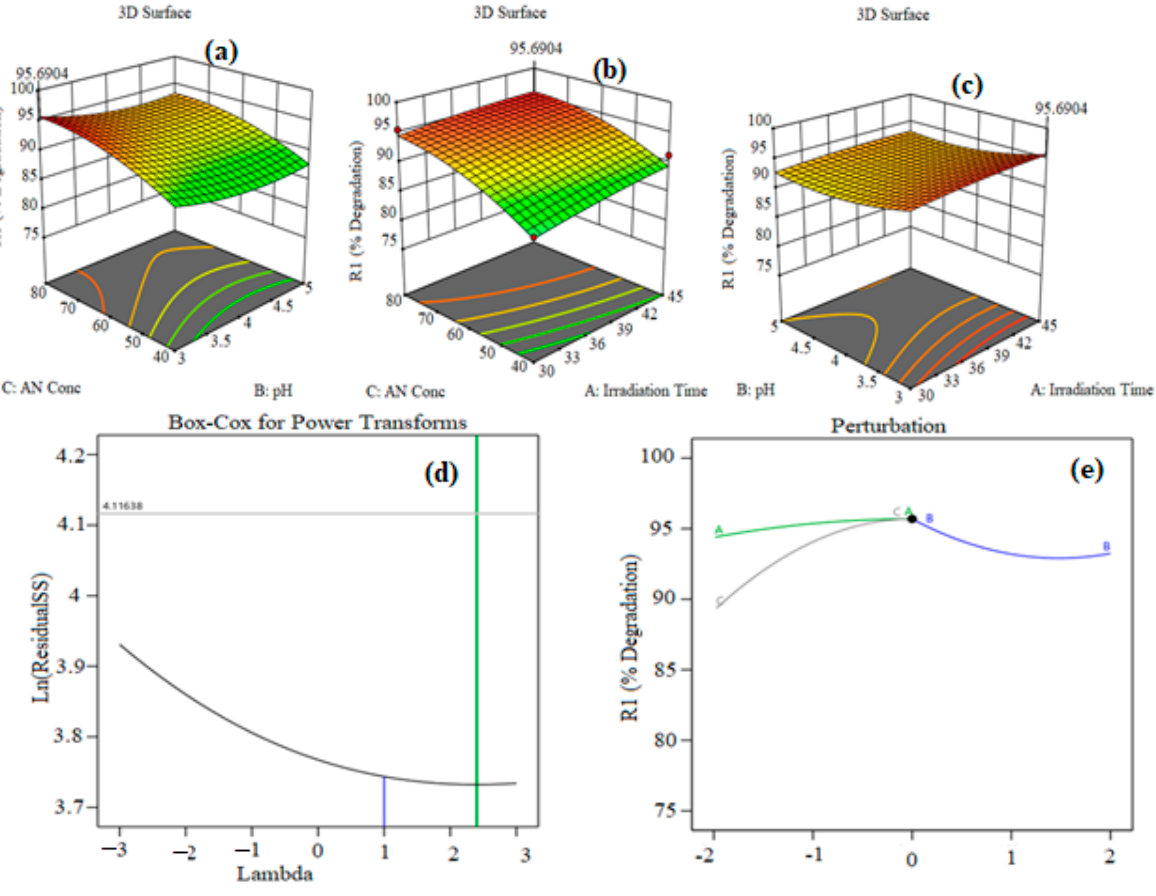
Figure 8. 3D surface interactive plots of ( a ) AN concentration vs. pH, ( b ) AN concentration vs. irradiation time, ( c ) pH vs. irradation time, ( d ) Box–Cox for power transformation and ( e ) pertubation curve.